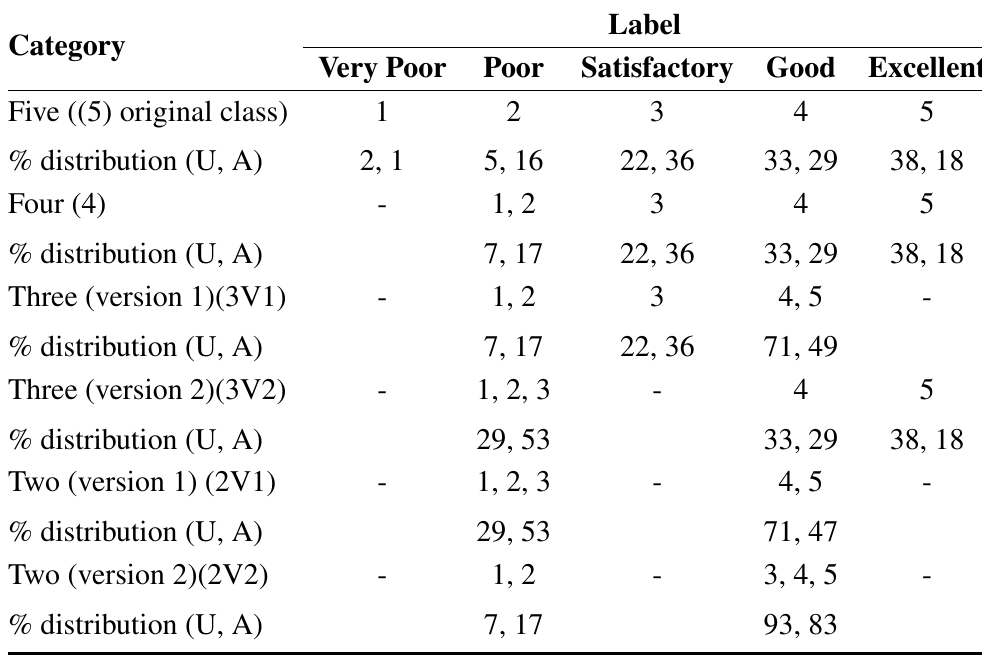
Table 1. Datasets re-clustered according to similarity of score into all possible combinations of